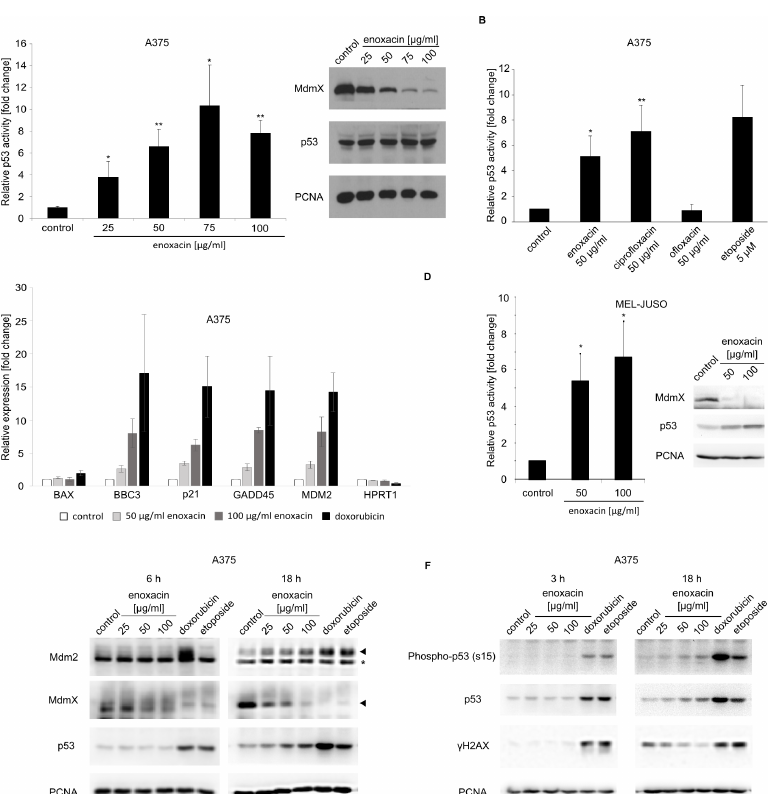
Fig 3. Enoxacin activatesp53-dependent transcription in melanoma cells overexpressing MdmX without inducing DNA damage. ( A, left ) A375 cells stably transfected with a p53-responsive luciferase reporter construct were grown for 24 hours in the presence of enoxacinin concentrations 25, 50, 75, and 100 μ g/ml. Relativep53 transcriptional activity was determined by measuring the activity of luciferase in cell lysates. Results of three independent experiments are presented(means + SD). * P < 0.05, ** P < 0.01 (Student’st-test, two-tailed). ( A, right ) A375 cells were treated with enoxacinfor 24 hours, lysed, and protein levels of MdmX and p53 in cell lysates were analyzedby Western blotting. PCNA served as a loadingcontrol. ( B ) A375 cells stably transfected with a p53 activity reporter construct were treated with 0.2% NaOH (control), etoposide, and three fluoroquinolone antibiotics, and p53 activity was determined. Results of three independent experiments (means + SD) are presented. A significantdifference betweencontrol and antibiotic-treated cells * P < 0.05, ** P < 0.01 (Student’s t-test, two-tailed). ( C ) Quantitative real-time PCR analysisof the expressionof selectedp53 target genesin A375 cells treated for 24 hours with 50 or 100 μ g/ml enoxacinor 0.5 μ M doxorubicin.The expressionof HPRT1/HGPRT served as an endogenouscontrol. ( D ) Mel-Juso cells stably transfected with a p53-responsive luciferase reporter construct were grown for 24 hours in the presenceof enoxacinin concentrations 50 and 100 μ g/ml. Relativep53 activity was determined by measuring luciferaseactivity in cell lysates. Results of three independent experiments are presented(means + SD). * P < 0.05,(Student’st-test, two-tailed). MdmX and p53 protein levels in Mel-Juso cell lysates were analyzedby Western blotting. PCNA served as a loadingcontrol. ( E ) ( F ) Western blot analysisof A375 cells treated with increasing concentrations of enoxacinor DNA damaging drugs for the indicatedtime. A mixture of three different primary monoclonal antibodiesrecognizingvariousepitopesin humanMdm2 was used in the Mdm2 panels. *